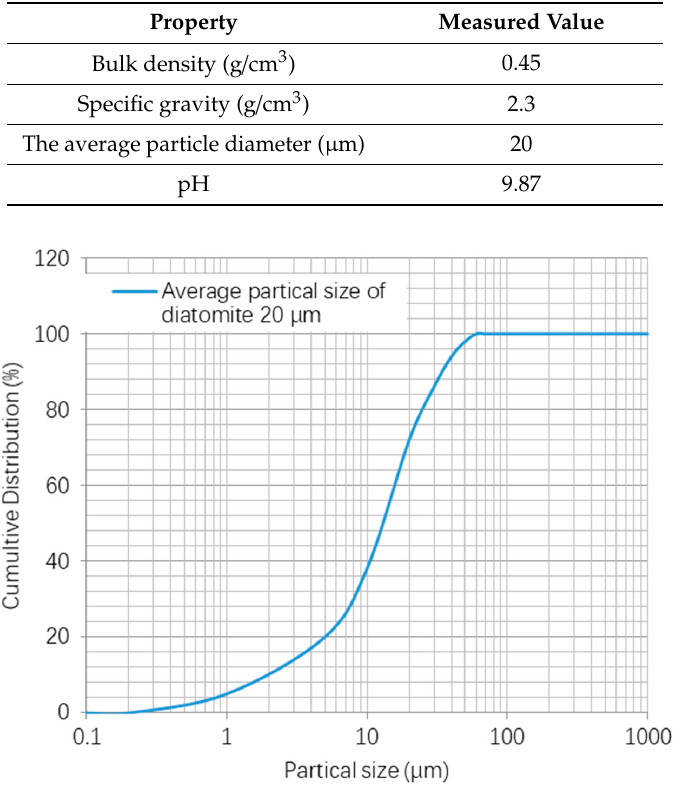
Figure 2. ( a ) View of lignin fiber; ( b ) diatomite.